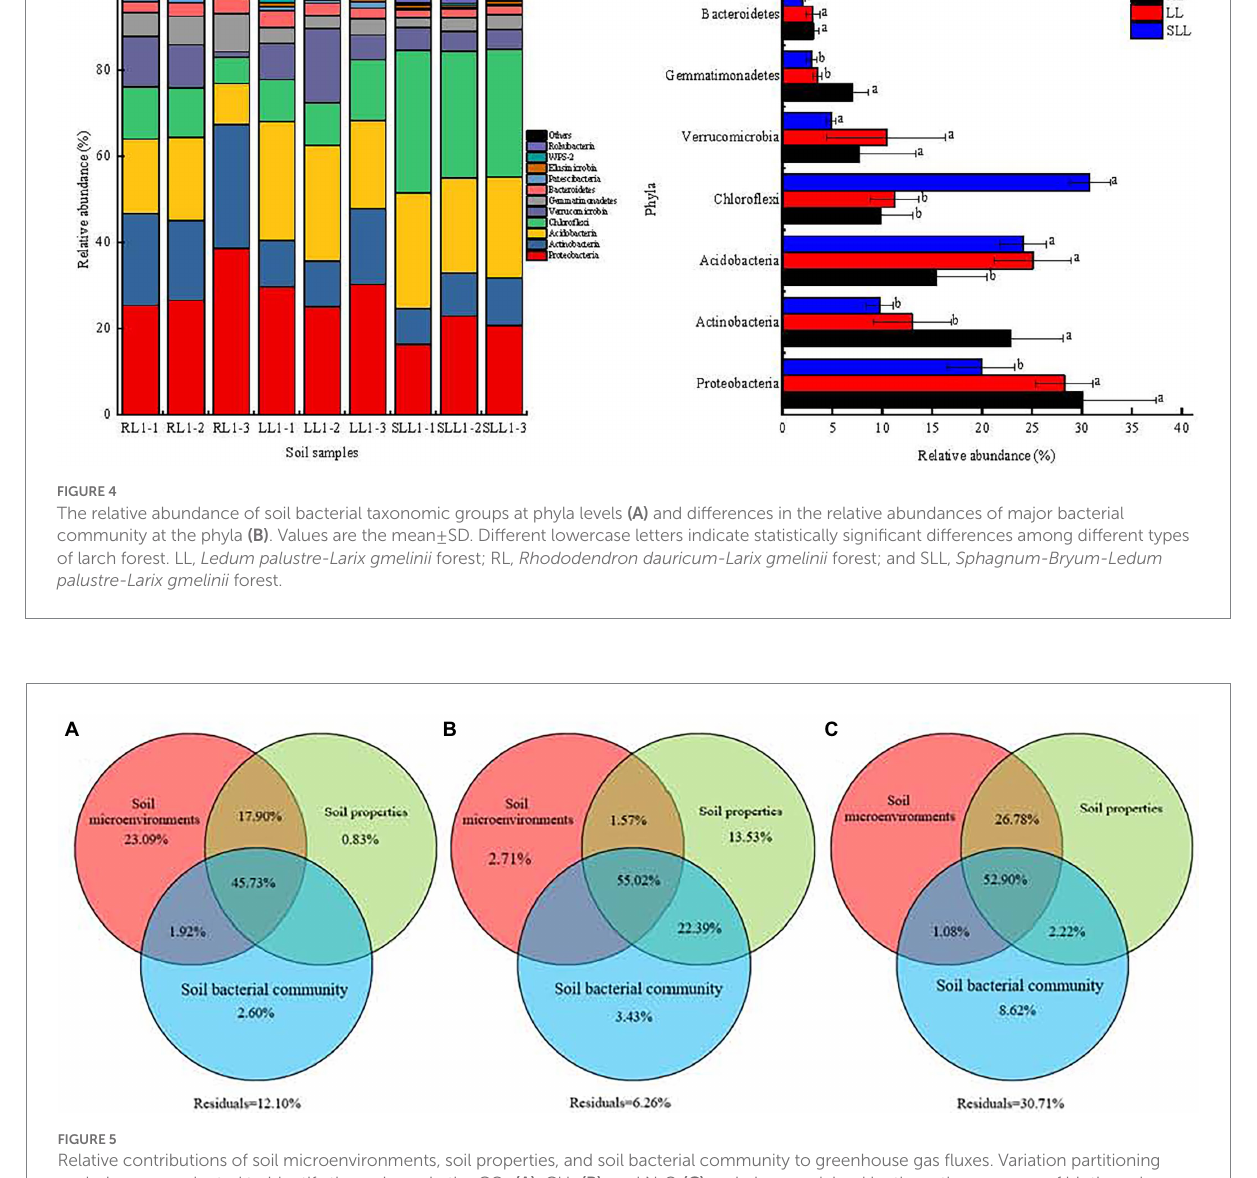
FIGURE 5 Relative contributions of soil microenvironments, soil properties, and soil bacterial community to greenhouse gas fluxes. Variation partitioning analysis was conducted to identify the variance in the CO 2 (A) , CH 4 (B) , and N 2 O (C) emissions explained by these three groups of biotic and abiotic factors. Values <0 are not